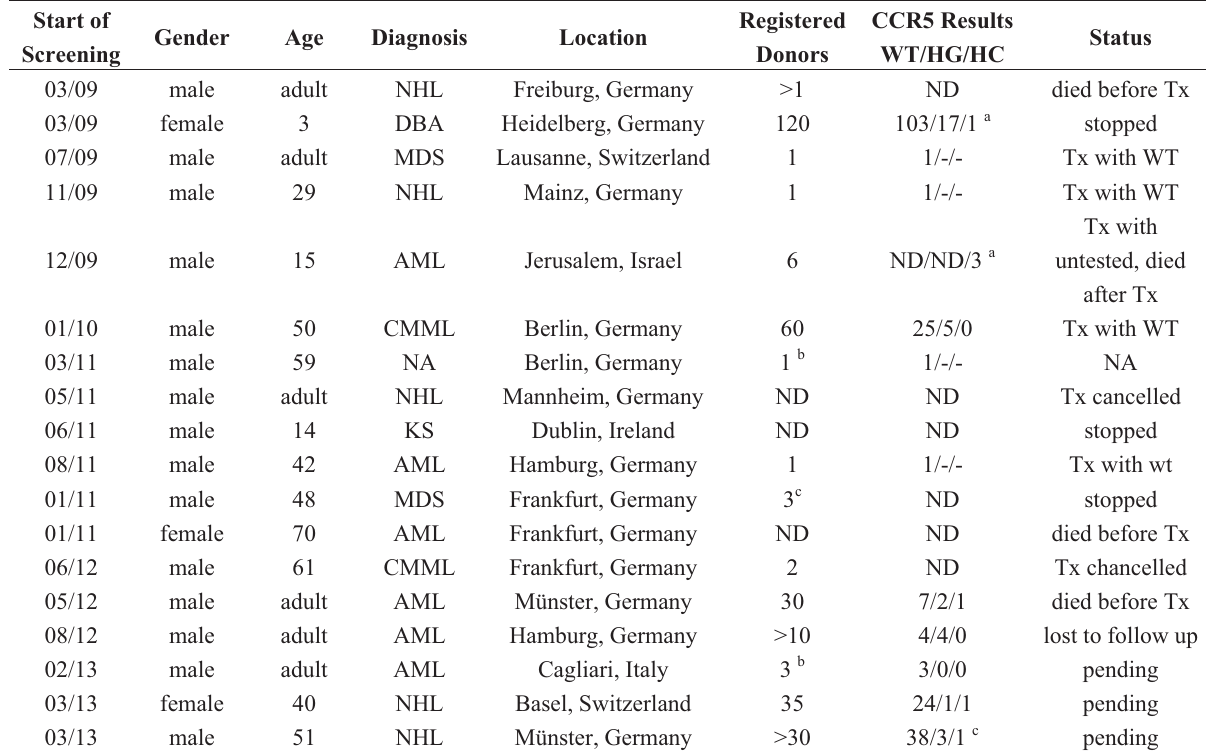
Table 1. Summary of 18 patient/donor screening series searching for a CCR5-delta32 homozygote stem cell